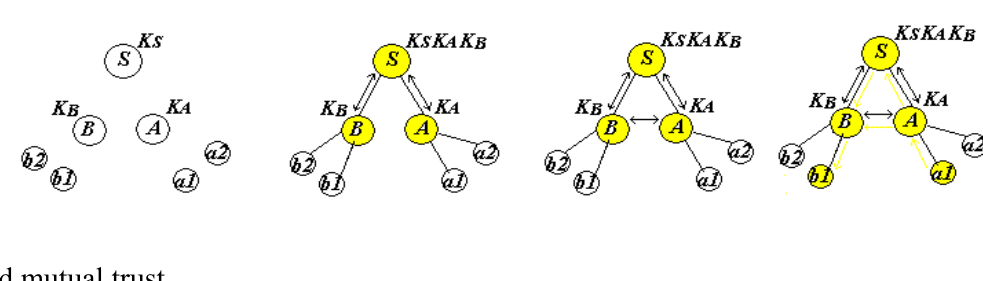
Figure 5. Hybrid mutual